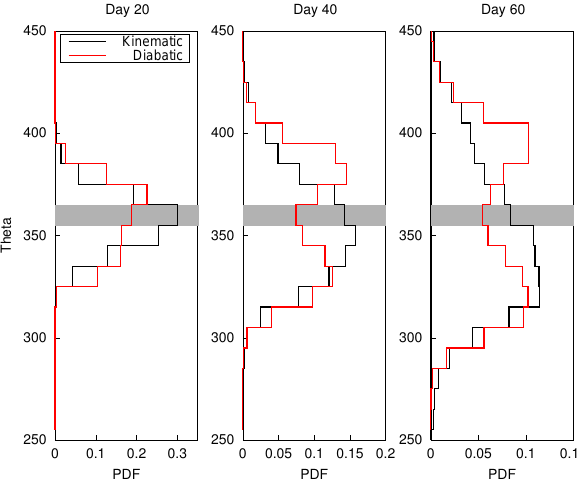
Figure 7. Mean distribution of trajectories with respect to potential temperature for kinematic (black) and diabatic (red) transport. The gray bar denotes the initial location.